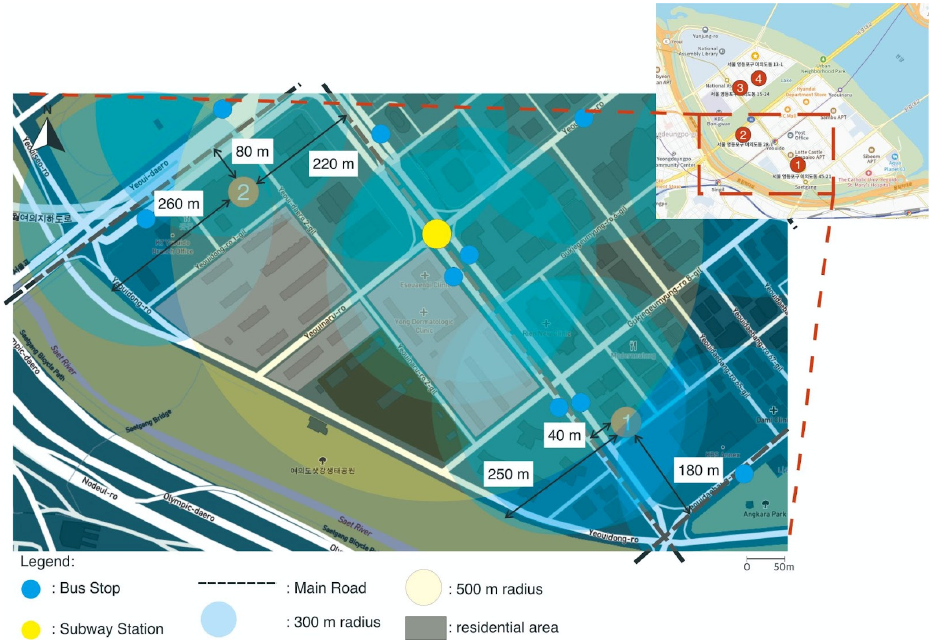
Figure 3. The proximity of Sample 1 and 2 from the bus stops, subway station, and nearby parks. Compared to the other samples, Sample 2 has the closest proximity to most facilities.